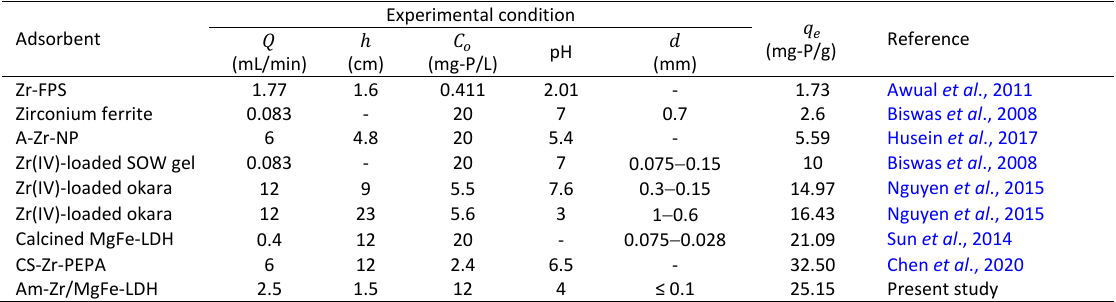
Table 2: Comparison of the phosphate adsorption capacity of am-Zr/MgFe-LDH composite with various adsorbents in fixed-bed column Experimental condition Adsorbent